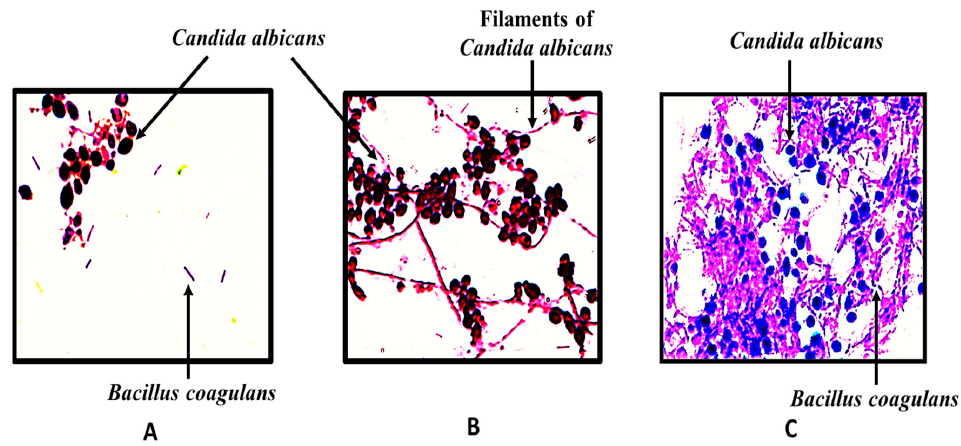
Figure 10. Co-aggregation of Candida albicans with ( A ) free Bacillus coagulans , ( B ) blank emulgel suppositories (absence of co-aggregates), and ( C ) Bacillus coagulans incubated with probiotic-loaded gelatin–oil suppositories.